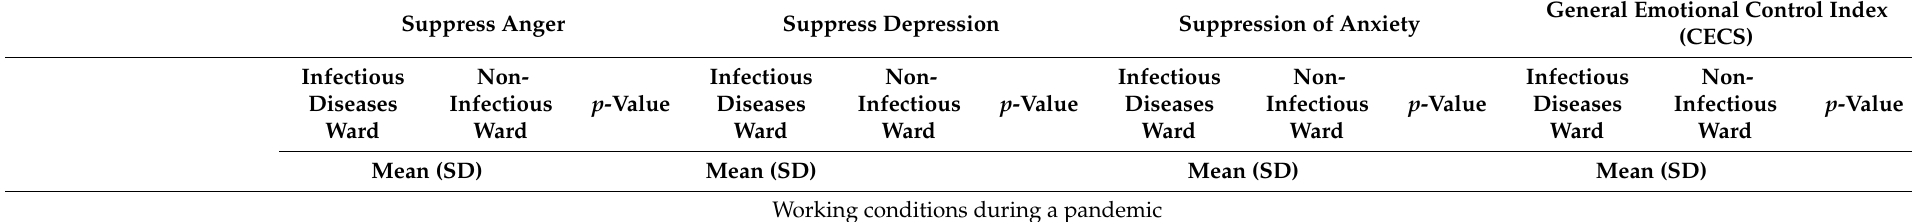
Table 3. Emotional control of the surveyed nurses depending on working conditions and depending on the support received during the COVID-19 pandemic. Suppress Anger Suppress Depression Suppression of Anxiety Infectious Non- Infectious Non- Diseases Infectious Diseases Infectious Ward Ward